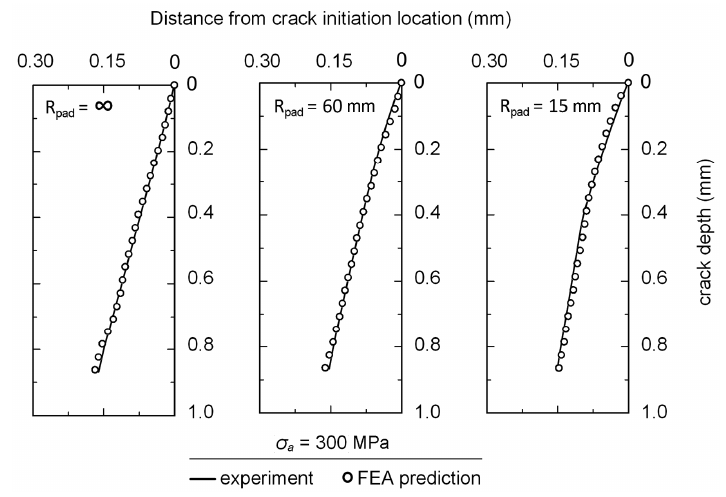
Figure 14. Fretting fatigue crack paths of fretting fatigue experiments at a stress amplitude of 300 MPa.